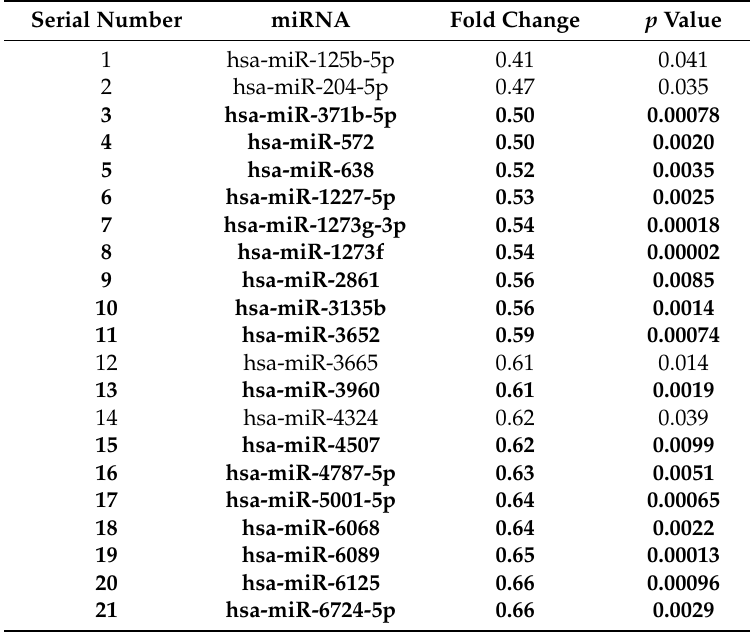
Table 4. Downregulated TAA miRNAs in Agilent’s Human miRNA microarray Release 19.0 †